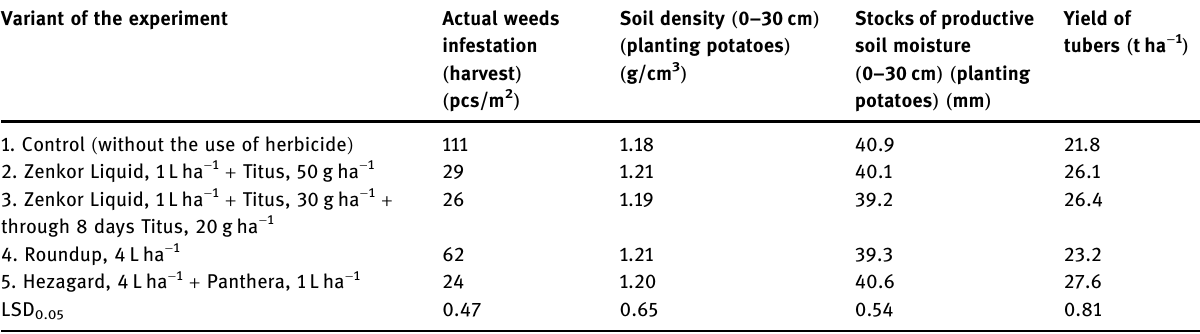
Table 2: Factors included for the development of the regression model ( average for 2017 – 2020 ) Variant of the